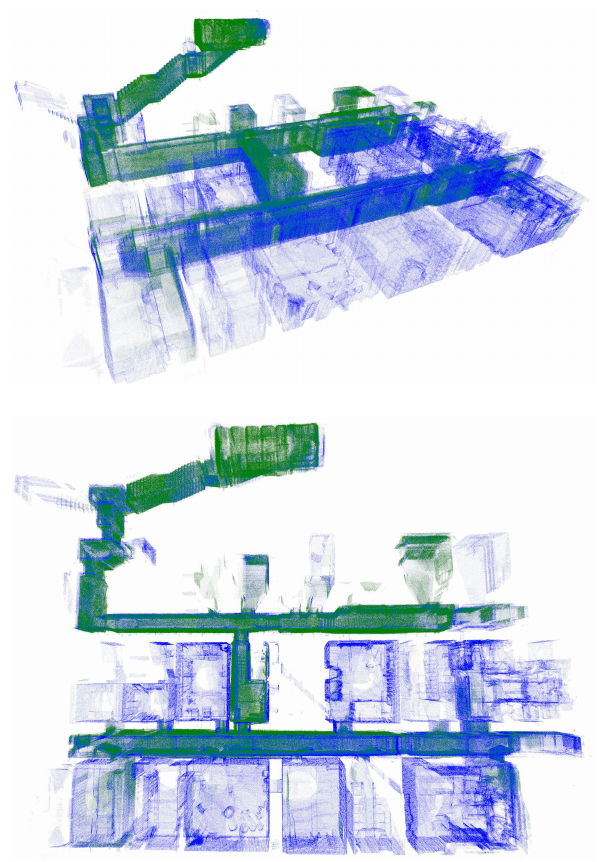
Figure 7. Comparison of the backpack point cloud with reference scans of the bunker created using a Riegl VZ-400 laser scanner. Co-registration of the mobile mapping point cloud (green) and the reference scans